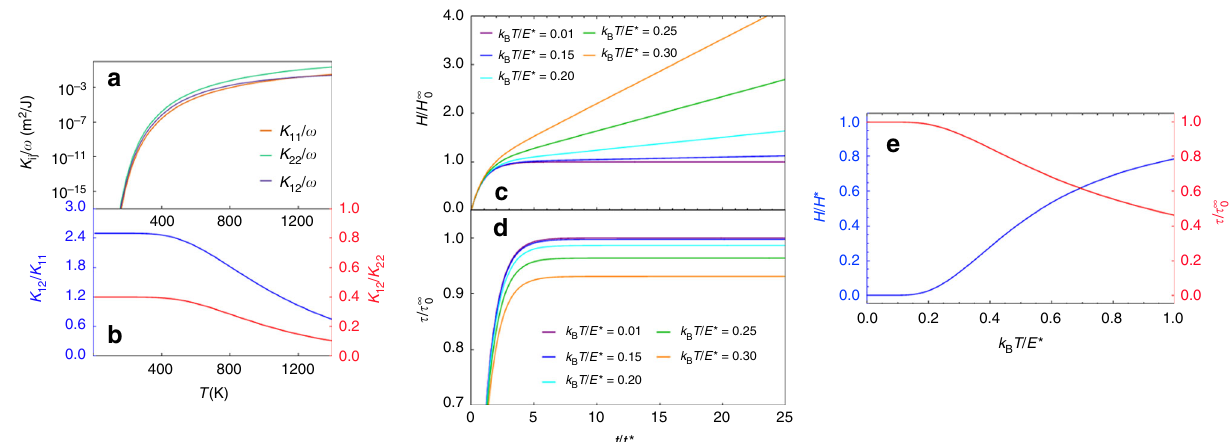
Fig. 9 Multi-mode Model. a Temperature dependence of the Onsager Coef fi cients K ij for the Σ 13 [001] (510) symmetric tilt GB in Ni, b the ratios K 12 / K 11 and K 12 / K 22 using Eq. (11). c τ ð t Þ = τ 1 and d H ð t Þ = H 1 as a function of time for various temperatures in the two-mode model. e lim t !1 τ ð t Þ = τ 1 0 0 _ H ð t Þ = _ H (cid:4) for the two-mode model as a function of temperature. t * is the time constant introduced in Eq. lim t !1